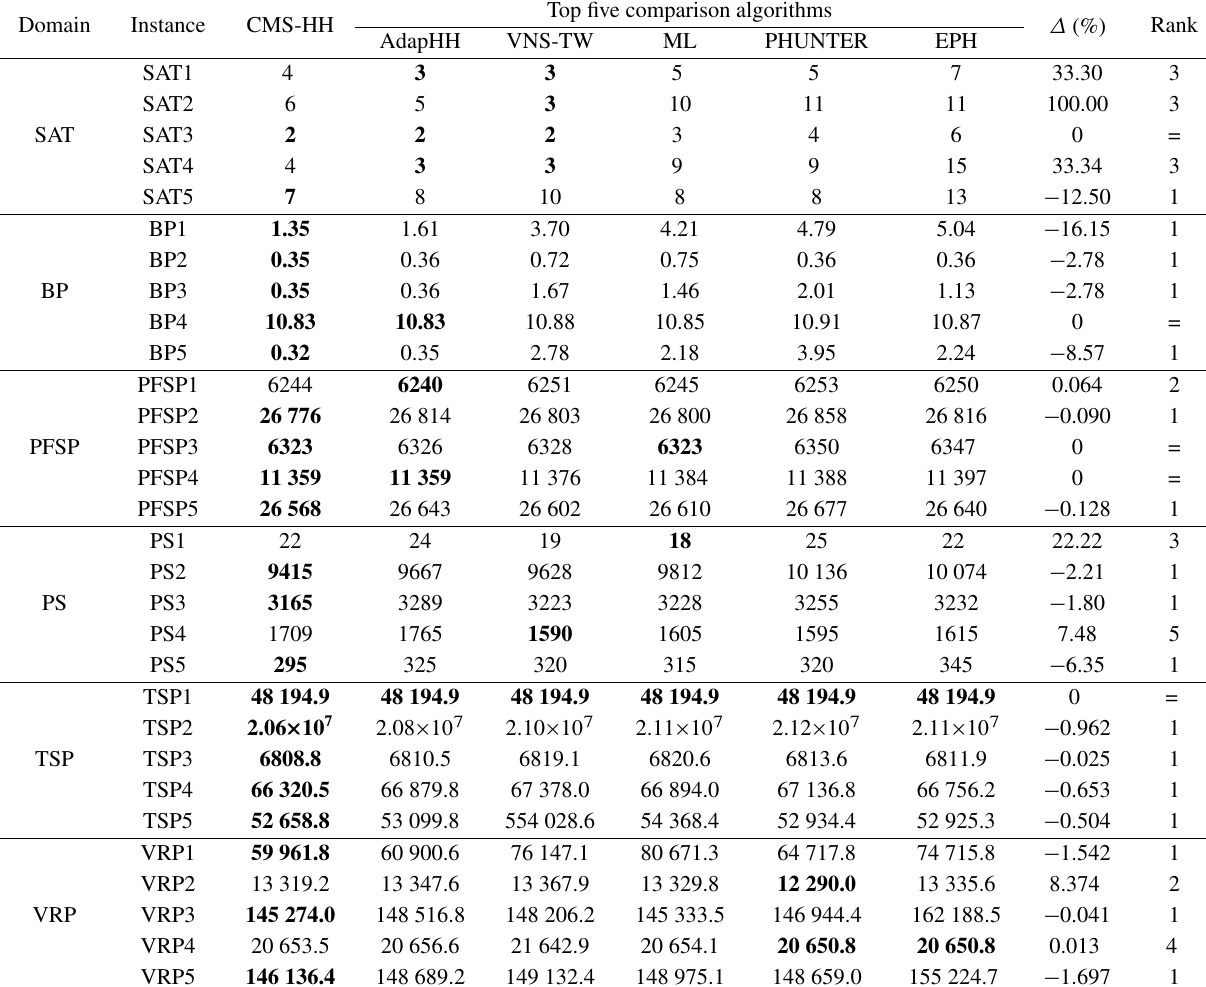
Table 12 Performance comparison of CMS-HH and five comparison algorithms based on the median objective values over 31 trials in different instances from six diverse problem